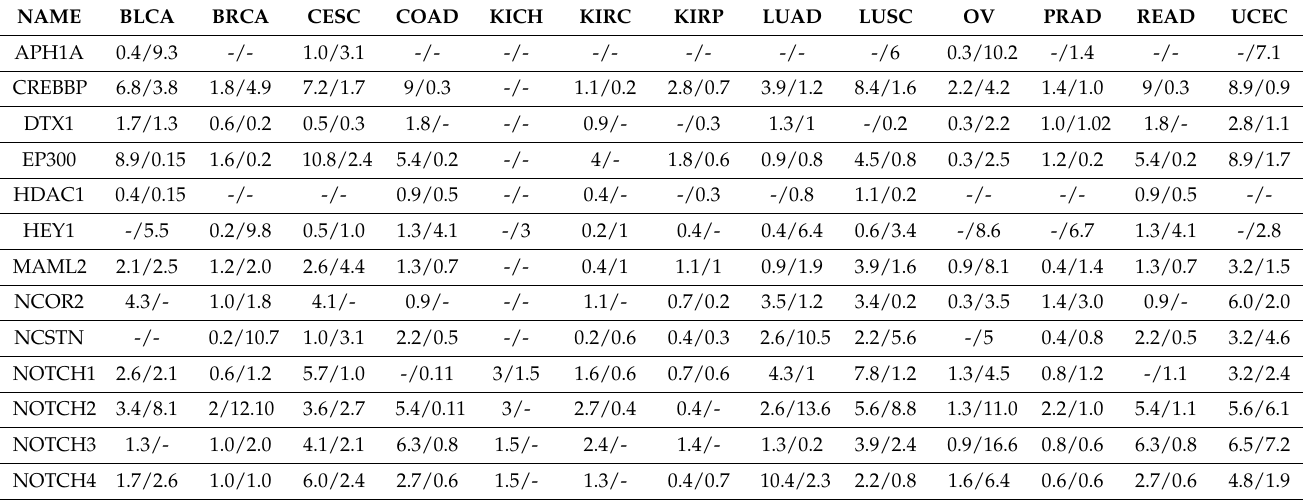
Table 4. Frequency of mutation and CNVs (mut/CNV) in core components of Notch. Table contains only those members for which values were found in